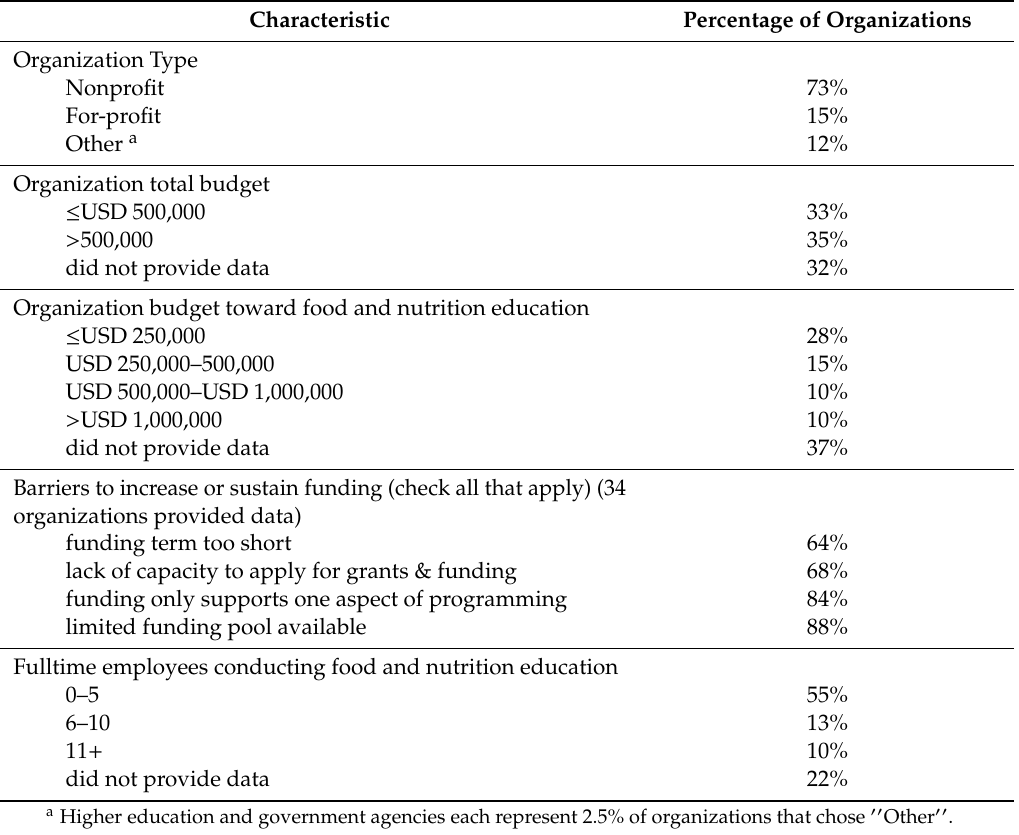
Table 1. Characteristics of Organizations Operating Food and Nutrition Education Programs in New York City Schools ( n = 40